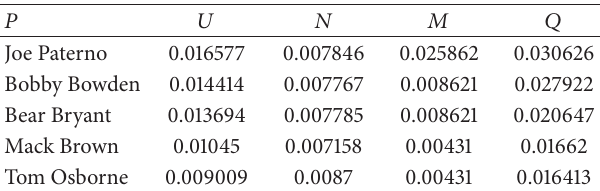
Table 12: Varies data after normalization (football).